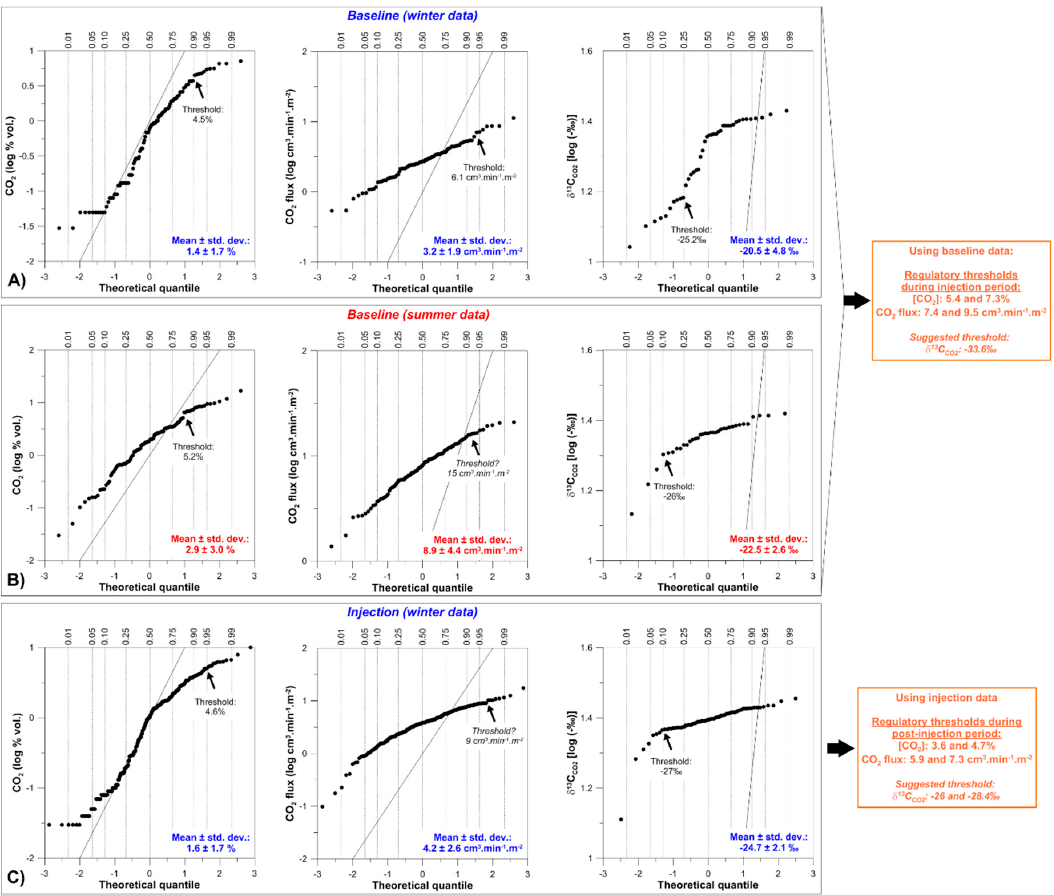
Figure 8. Log-probability plots for CO 2 concentrations, CO 2 -fluxes and δ 13 C CO2 isotope ratios. ( A ) winter baseline data; ( B ) summer baseline data; ( C ) winter injection data. Mean value and standard deviation of the dataset are indicated in each plot. The threshold definition that was used during pilot activity is indicated for comparison.